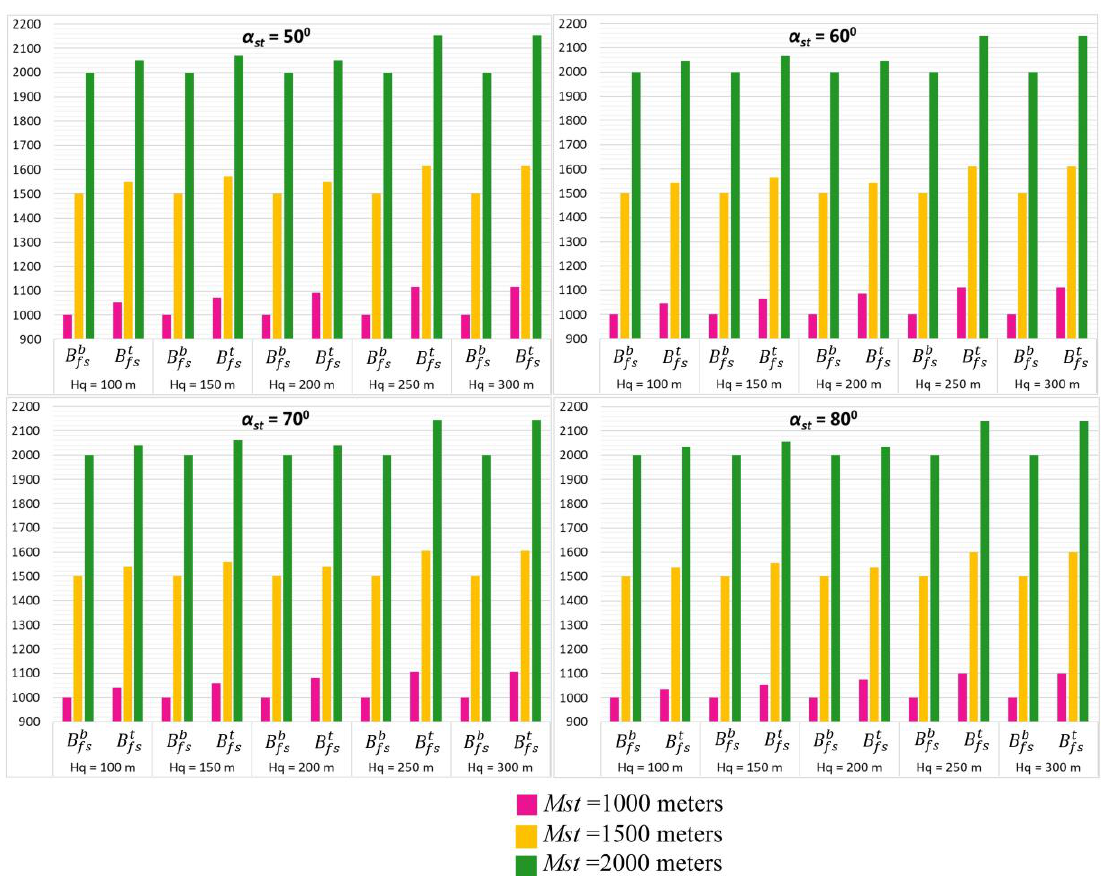
Figure 10. A family of diagrams of first-stage pit width B fsb (bottom) and B fst (top) in accordance with strata dip angle a st .